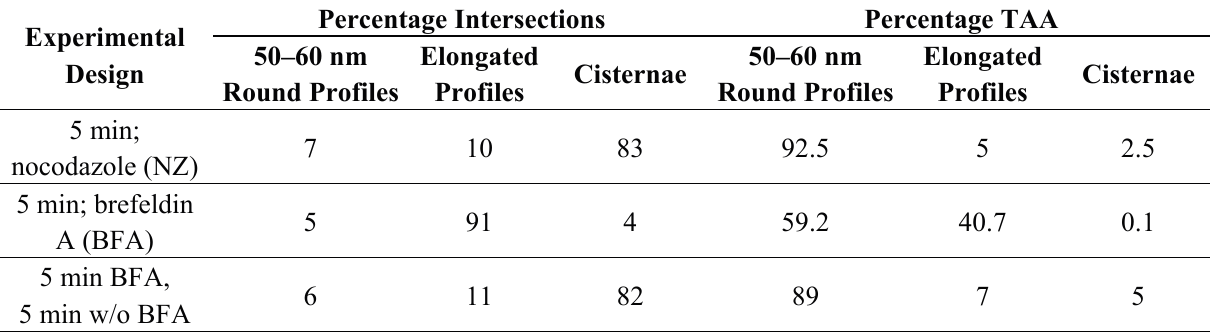
Table 1. Distribution of the trans- membrane area asymmetry (TAA) between the structural elements of the